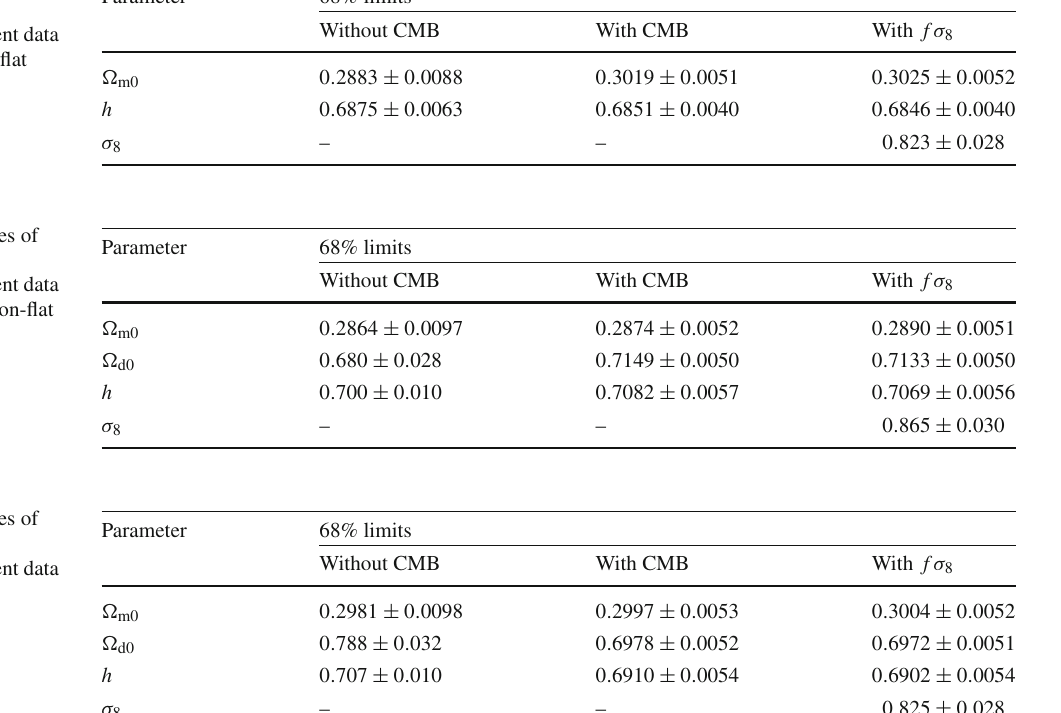
Table 3 The best fit value of free parameters and 1 σ uncertainties using different data sets for (cid:2) CDM model in flat universe